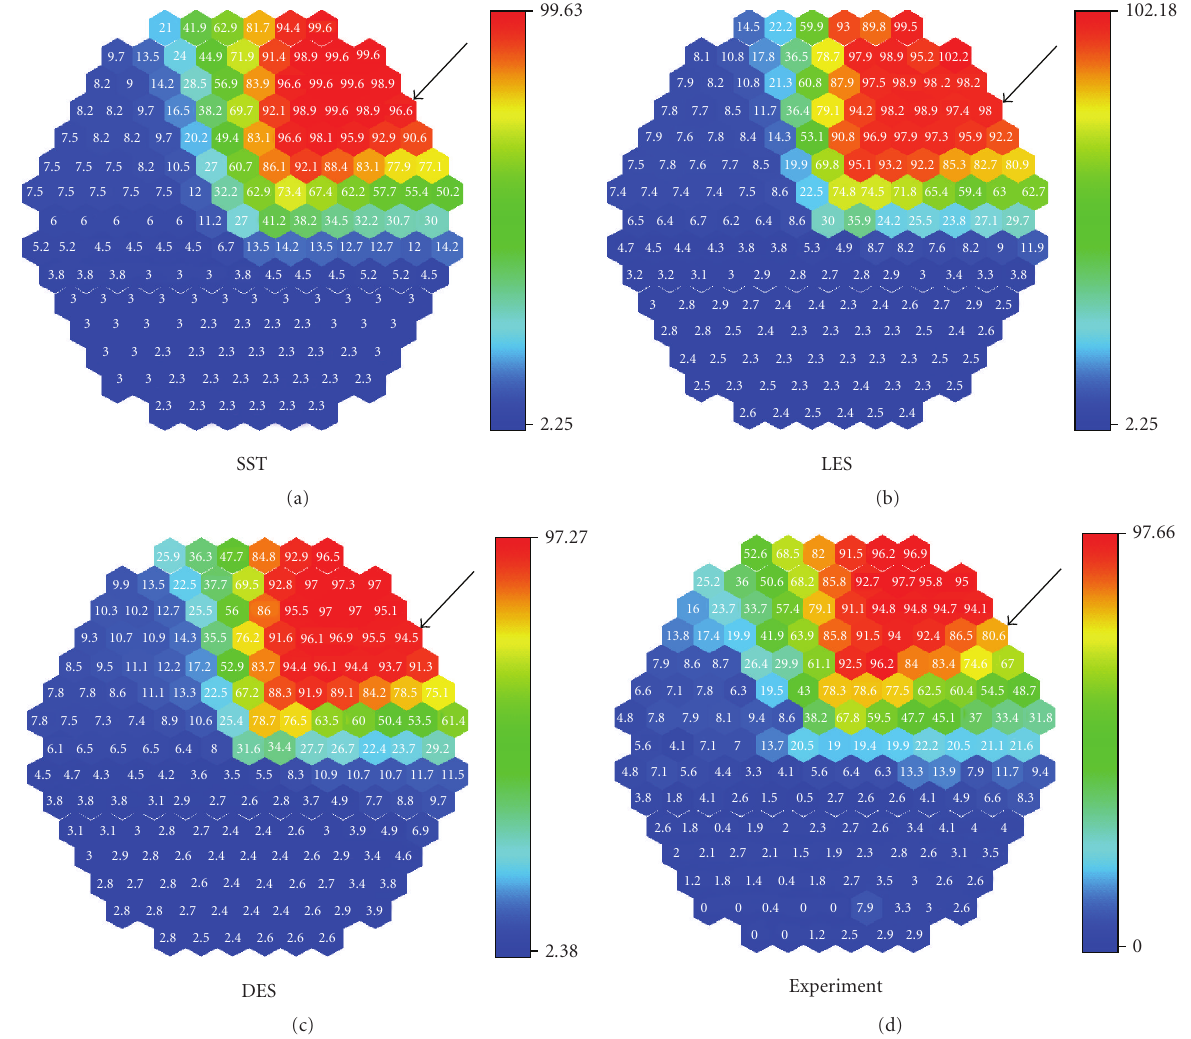
Figure 11: Relative temperature rise [%] at the core inlet calculated with the three di ff erent turbulence models.